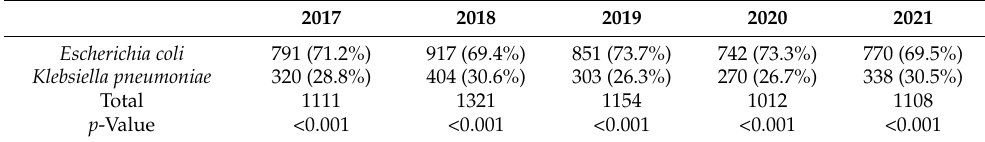
Table 1. Number of tested strains of each microorganism isolated from infections in